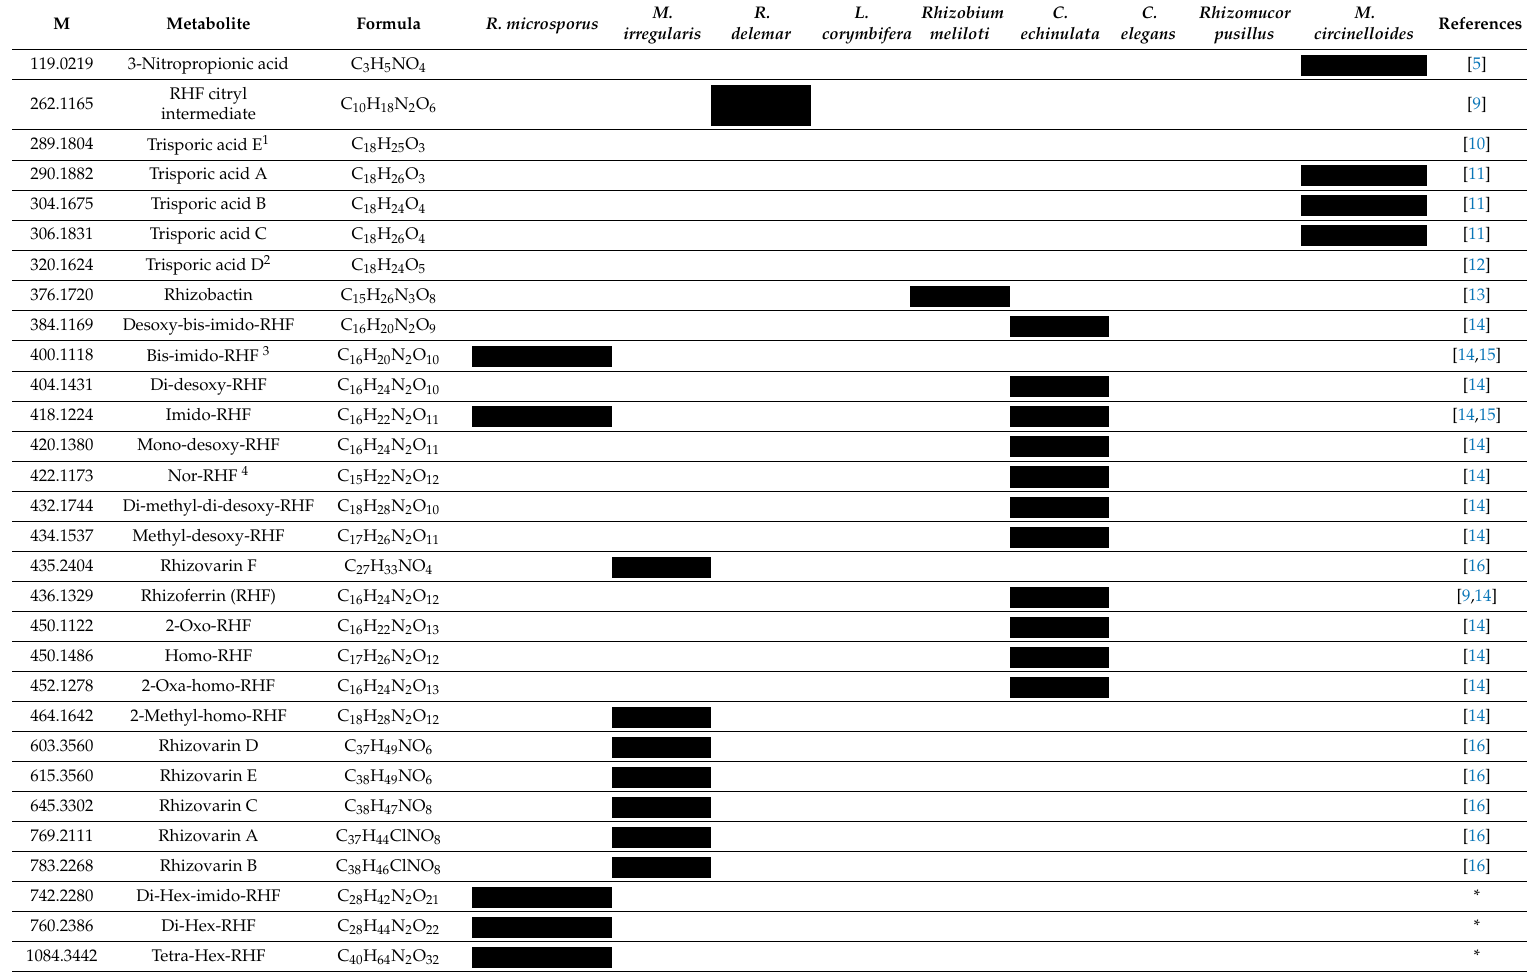
Table 1. Small molecules described in Mucorales. If not stated otherwise, the abbreviated genera M., R ., L., and C . stand for Mucor, Rhizopus, Lichtheimia , and Cunninghamella , respectively. M: monoisotopic molecular weight; RHF: rhizoferrin; 1 Reported in Phycomyces blakesleeanus ; 2 Described in Blakeslea trispora ; 3 Known also as glomuferrin [8]; 4 Known as staphyloferrin; * This